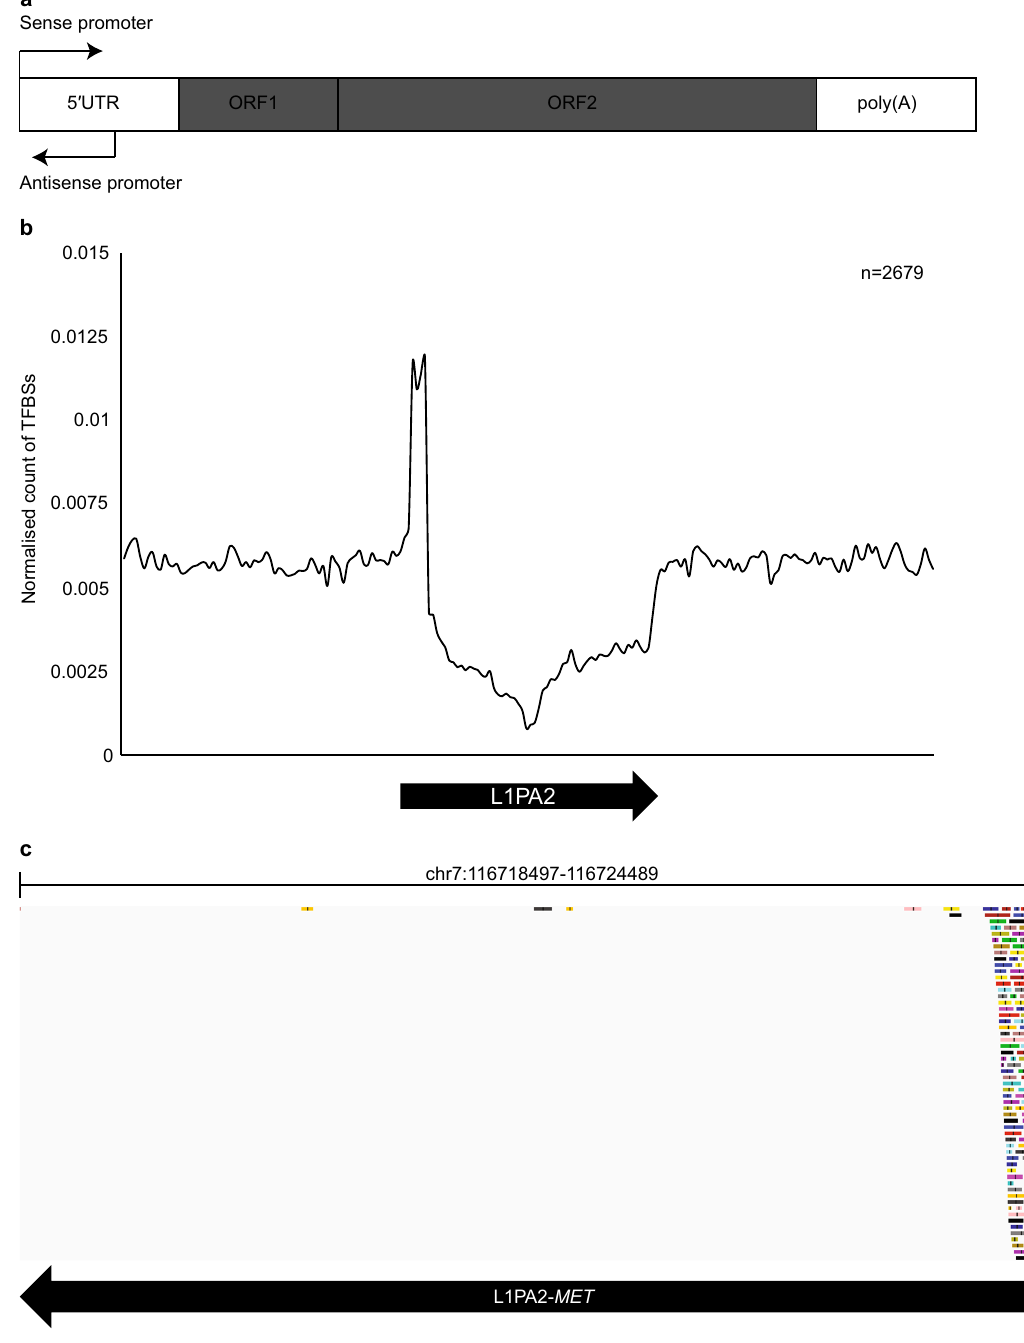
Figure 1. Distribution of TFBSs in human L1PA2 transposons and surrounding regions. ( a ) A typical LINE1 transposon, approximately 6 kb in length, contains a 5 ′ UTR, two ORFs and a 3 ′ poly(A) tail 1,29,30 . ( b ) The 5 ′ UTR of L1PA2 was a prominent source of TFBSs. The normalised counts of TFBSs in the 20 kb region (bin = 100 bp) centred on L1PA2 transposons are shown, averaged by the total number of L1PA2 harbouring at least one GTRD meta cluster (n = 2,679). While the majority of L1PA2 structures showed a depletion of TFBSs, the 5 ′ UTR was a prominent reservoir of TFBSs. ( c ) Example GTRD browser view of TFBS distribution in L1PA2 transposons. The TF binding distribution in the L1PA2 transposon located upstream of the MET gene was visualised on the GTRD browser 39 . Each rectangular track indicates a TF binding meta-cluster. The black arrow indicates the position and orientation (5 ′ to 3 ′ ) of the L1PA2